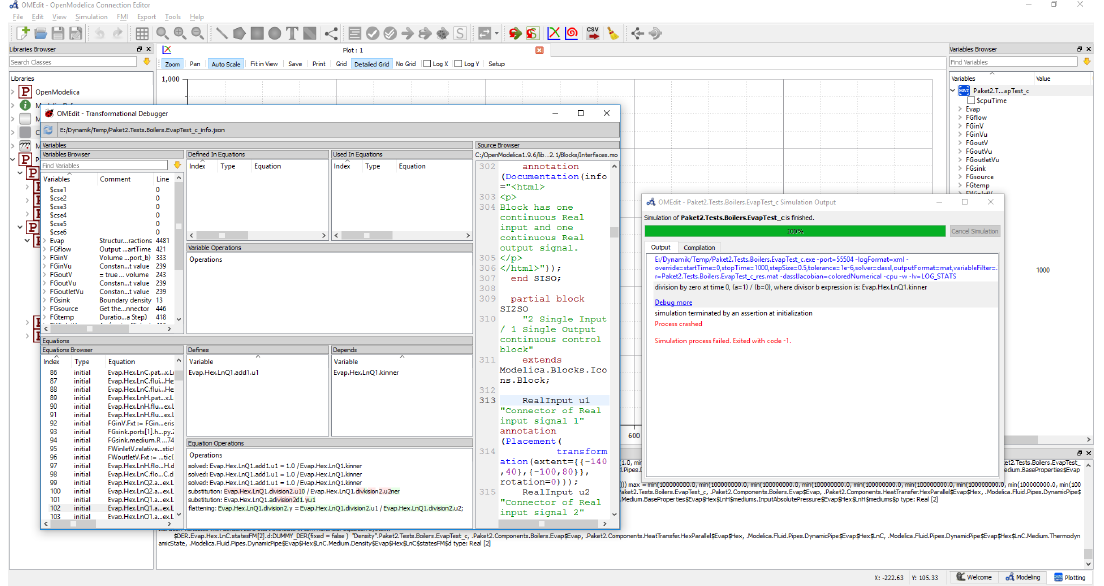
Figure 6: Debugger activated after division by zero by parameter